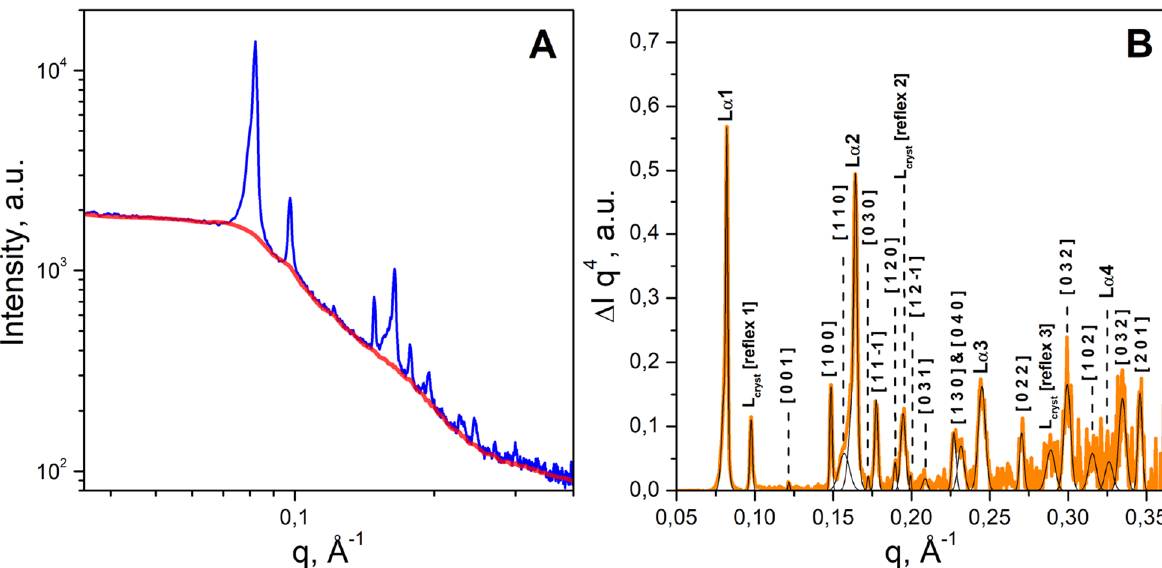
Figure 5. SAXS data from the crystallization matrix after crystal formation (BM29, ESRF). ( A ) The SAXS curve for the crystallization matrix with crystals (blue curve) and the corresponding baseline (red curve). ( B ) The SAXS curve from the crystallization matrix after baseline subtraction (orange). Intensity is multiplied by q 4 for better observation of the wide-angle peaks. The Gaussian approximations of the peaks are represented in black. The Miller indexes (for BR crystals) and the reflex numbers (for the lipidic multilayers Lα or L cryst ) are marked above the corresponding peaks (for more details, see Table S4).